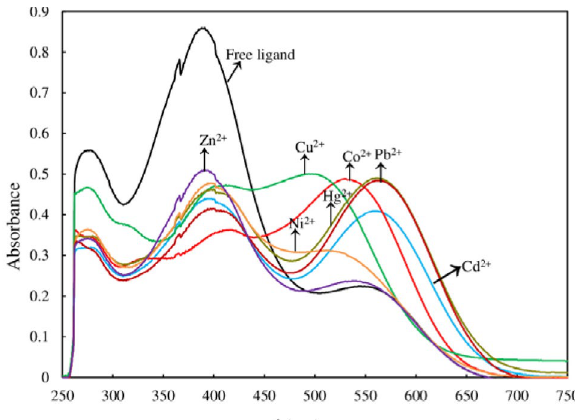
Fig. 3 . UV–vis spectra of ligand 2 (0.01 mM) before and after add- ing a 0.01 mM concentration of various metal acetates in a DMSO solution.